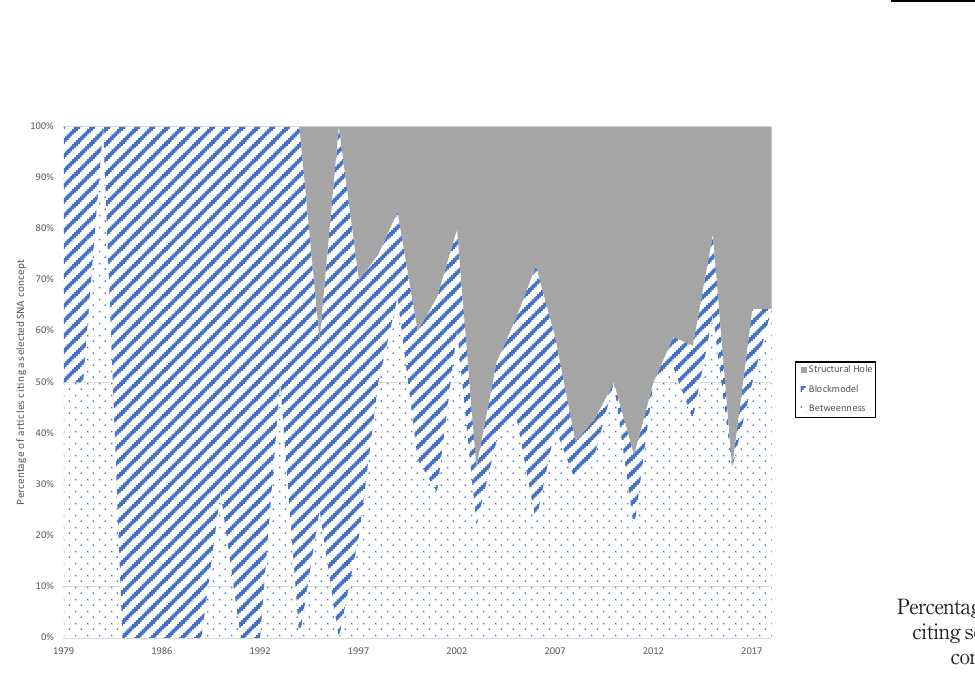
Figure 1. Evolution of articles citing selected SNA concepts at top